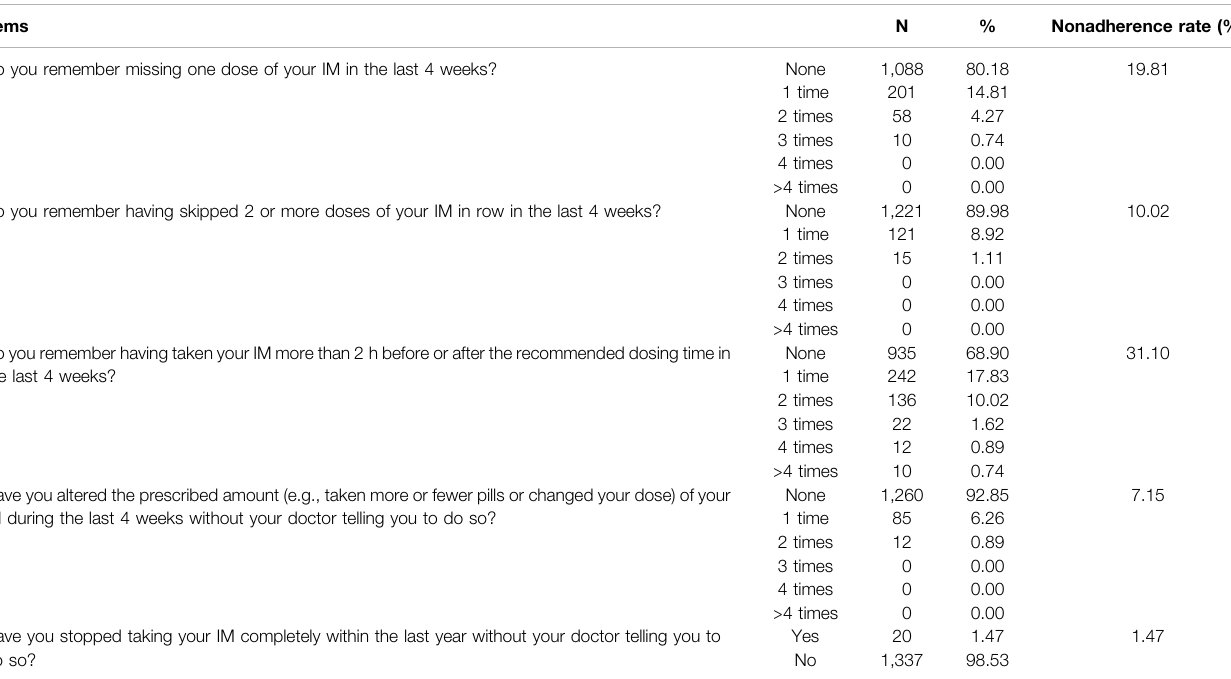
TABLE 2 | Adherence to IM measured by BAASIS. items N